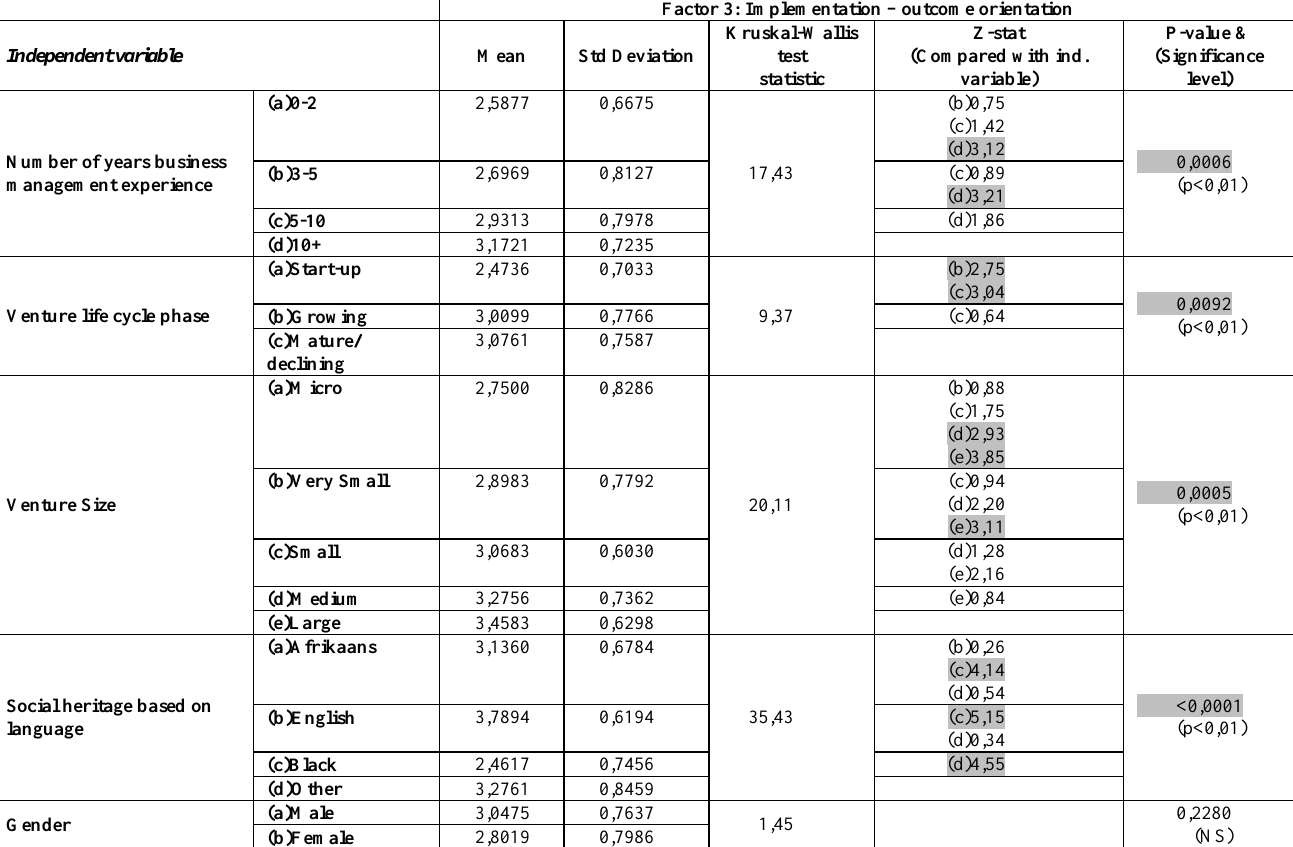
Table 5: Pair-wise analysis of Implementation-outcome orientation with independent variables Factor 3: Implementation – outcome